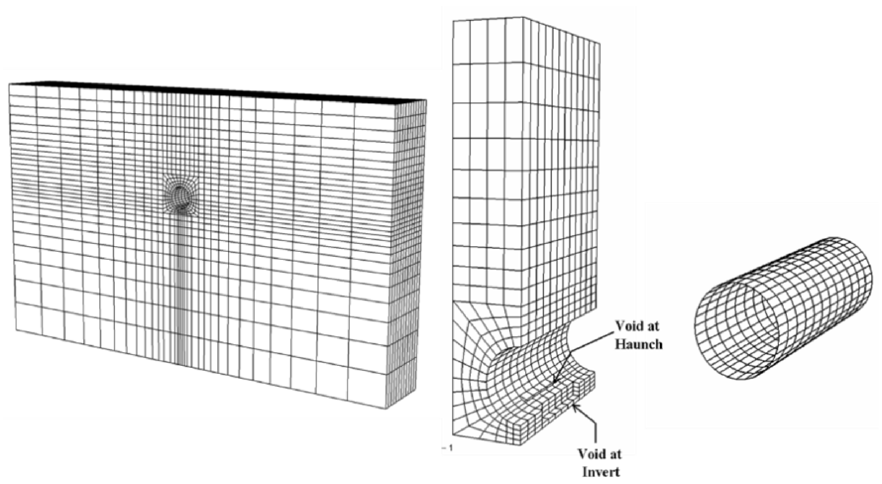
Figure 1. Finite element mesh for simulations.